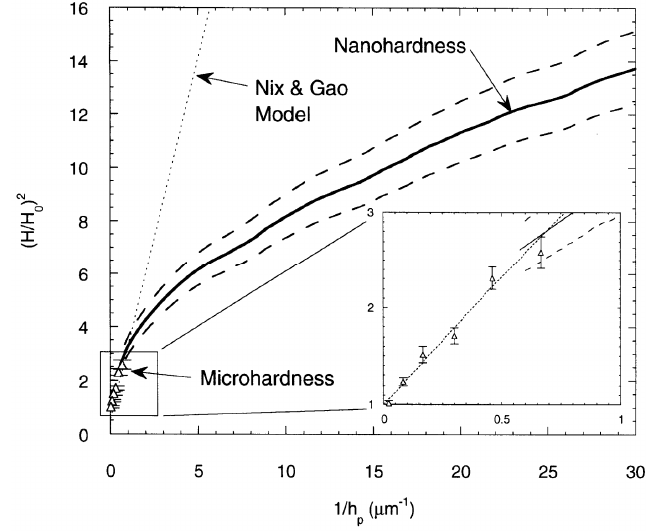
Figure 4. Indentation size effect in annealed iridium measured with a Berkovich indenter ( ∆ and solid line) and comparison of experiments with the Nix and Gao [13] model ( H 0 = 2.5 GPa; h ∗ = 2.6 µ m ) . The dashed lines represent ±1 standard deviation of the nanohardness data (after Swadener et al. [14]).